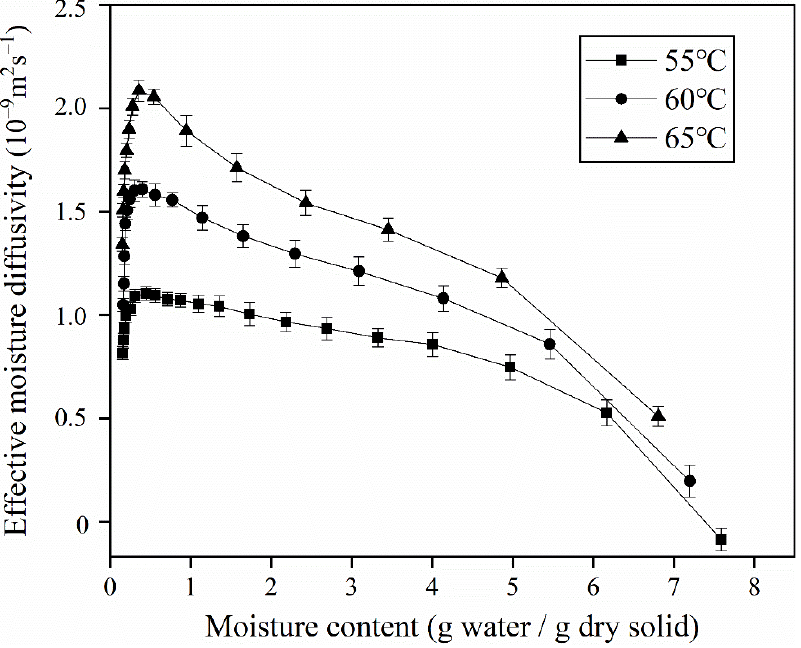
Figure 3. Effective moisture diffusivity versus moisture content of cantaloupe slices under different SMIR drying temperatures (slice thickness 7 mm, radiation distance 120 m).